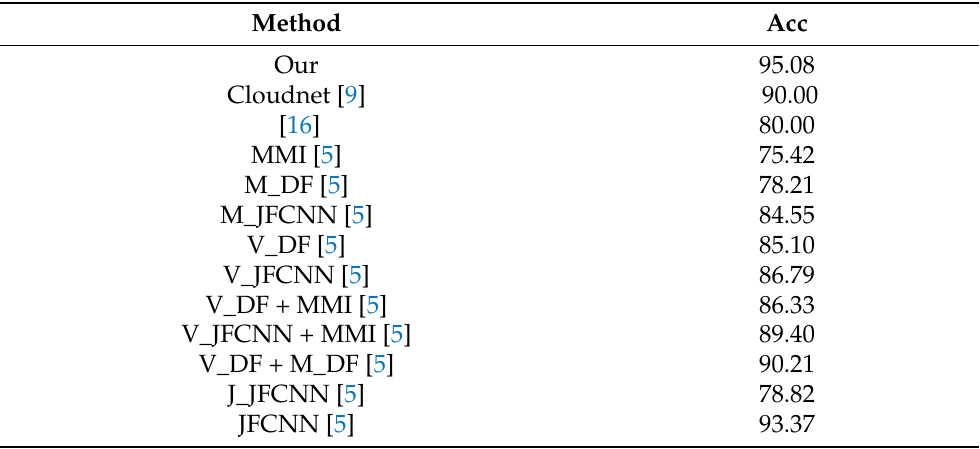
Table 8. Experimental results on CCSN